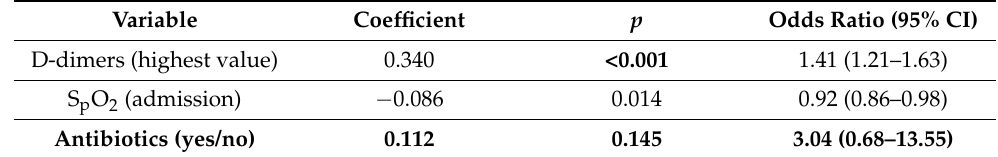
In the subgroup of patients with reasons for antibiotic prescription, only D-dimers (highest value) and S p O 2 at admission were independent predictors of death (Table 5), while antibacterial therapy remained statistically associated with death even after adjustment among the patients without reasons for antibiotic treatment (Table 6). Table 5. The association of antibiotic treatment with death in the patients with reasons for prescription, after the adjustment for the prognostic factors (logistic regression) .